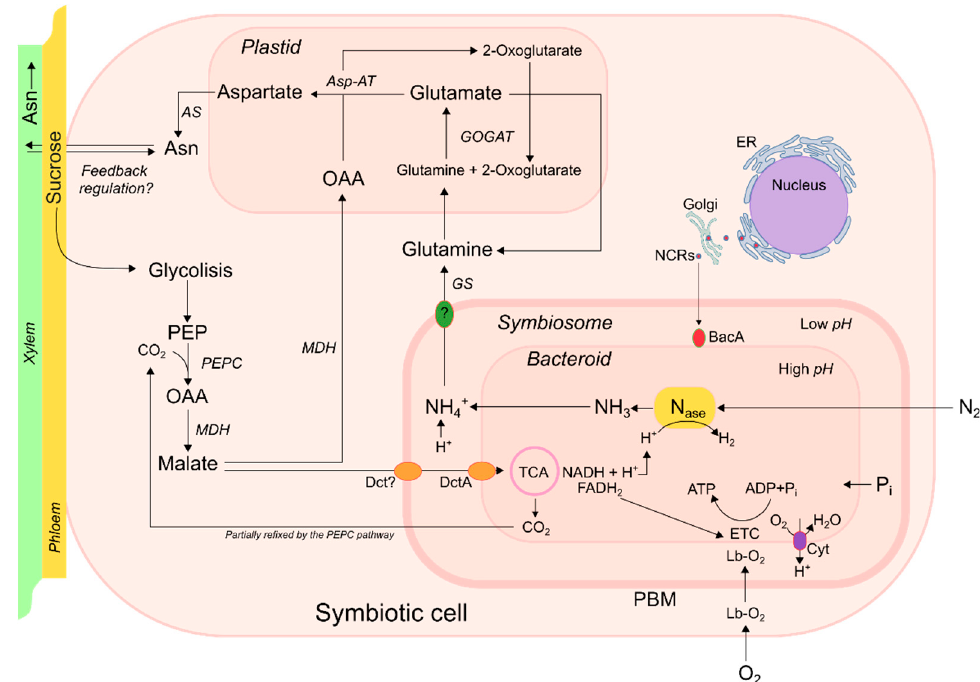
Figure 1. Infected cell with a differentiated bacteroid in an indeterminate nodule. Nitrogenase reduces di-nitrogen (N 2 ) into ammonia (NH 3 ) in the inner space of the bacteroid (high pH), which is then protonated into ammonium (NH 4+ ) in the symbiosome space (low pH). Leghemoglobin (Lb) transports O 2 to the bacteroid cytochrome (Cyt) of the electron transport chain (ETC). Sucrose is downloaded in the cytoplasm, where it is transformed by glycolysis pathways (PEPC-MDH) into malate, the main source of carbon skeletons for N transport out of the nodule and reductant power for driving N 2 fixation. Malate is transported by dicarboxylate transport (Dct and DctA), either placed in the peribacteroid membrane (PBM) or the bacteroid membrane. A cation channel permeable to NH 4+ has been proposed as exporting NH 4+ across the PBM [69]. NH 4+ is transformed into asparagine (Asn) through the GS-GOGAT pathway using oxaloacetate (OAA) as a substrate. Asn is most likely involved in a negative feedback regulation of N 2 fixation. Part of the CO 2 from the tricarboxylic acid (TCA) cycle is recycled by the phosphoenolpyruvate carboxylase (PEPC). Nodule-specific cysteine-rich (NCR) peptides drive the final transformation of bacteria into a bacteroid by a recognition protein system (BacA) located in the bacteroid membrane. Figure adapted from: Fischinger [70], Oldroyd et al. [67], Udvardi and Poole [63], and Sulieman and Tran